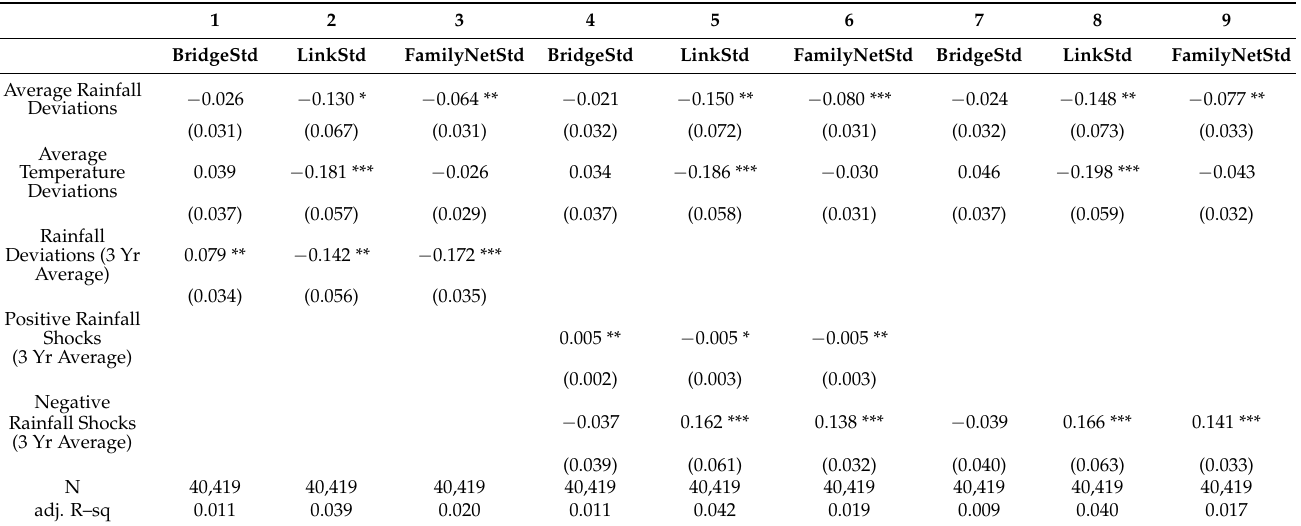
Table 2. Results assessing the impacts of climate shocks (3-year averages) on the key measures of social capital.